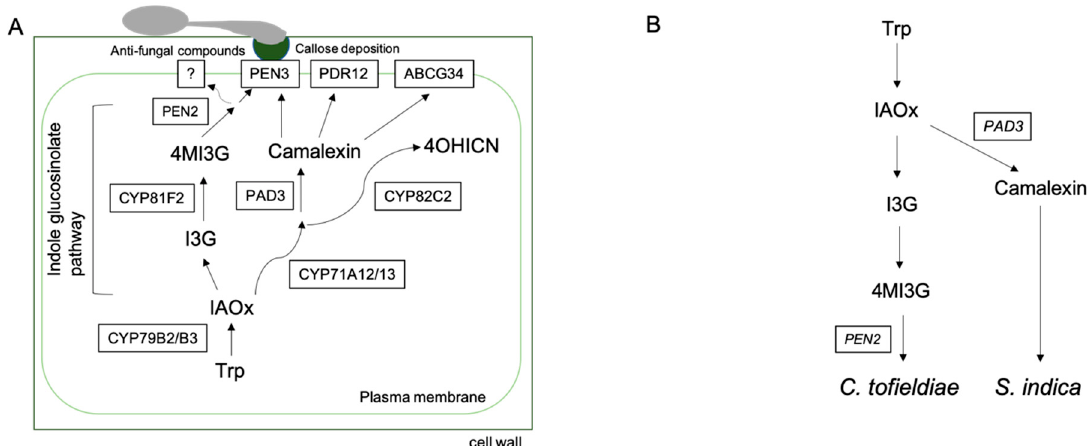
Figure 1. Overview of the tryptophan-derived metabolite pathway required for plant–microbe interactions. ( A ) Tryptophan (Trp) is converted to indole-3-acet aldoxime (IAOx) by the cytochrome P450 members CYP79B2 and CYP79B3. The indole glucosinolate pathway, the camalexin pathway,